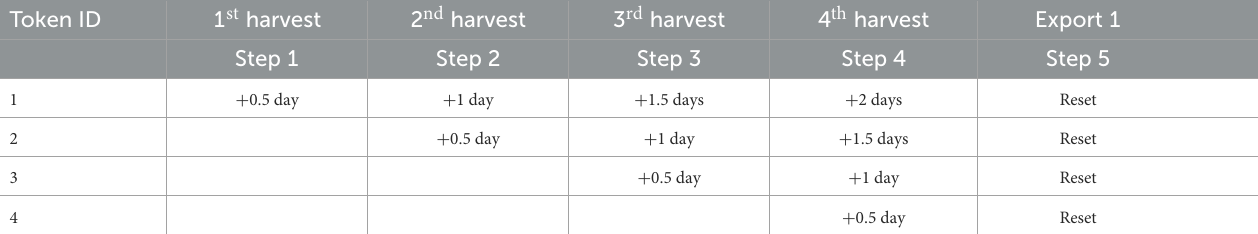
TABLE 2 Mango shelf-life in an export cycle.